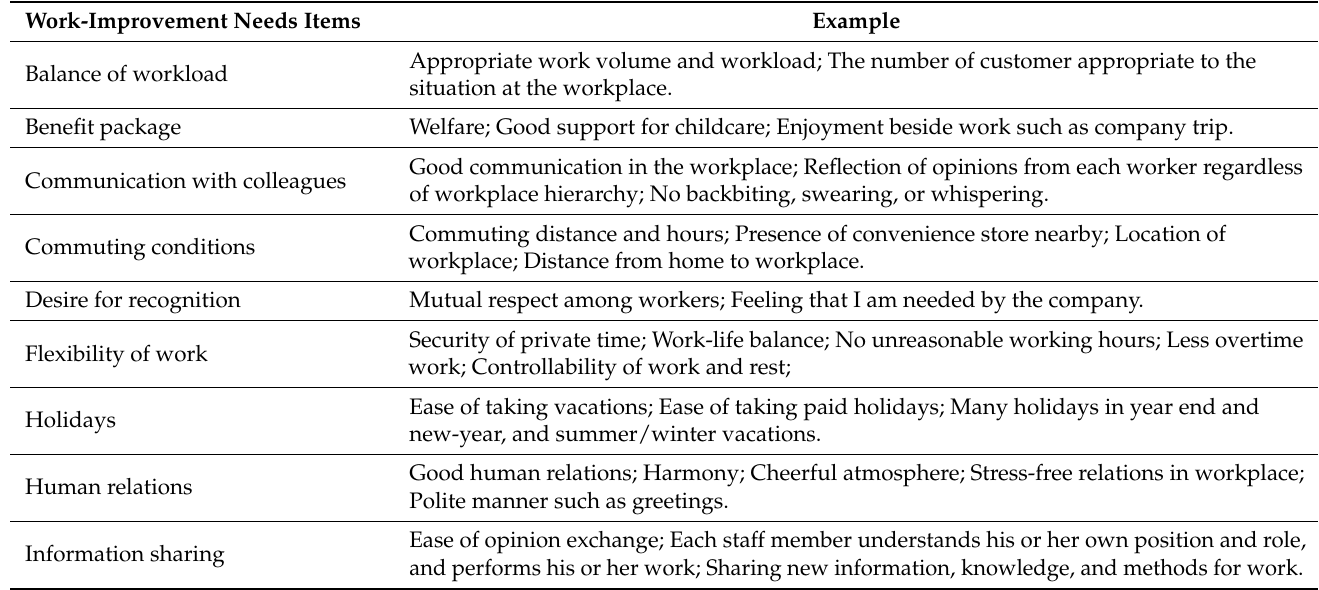
Table 4. Work-improvement needs items generated by summarising the cues regarding pleasant